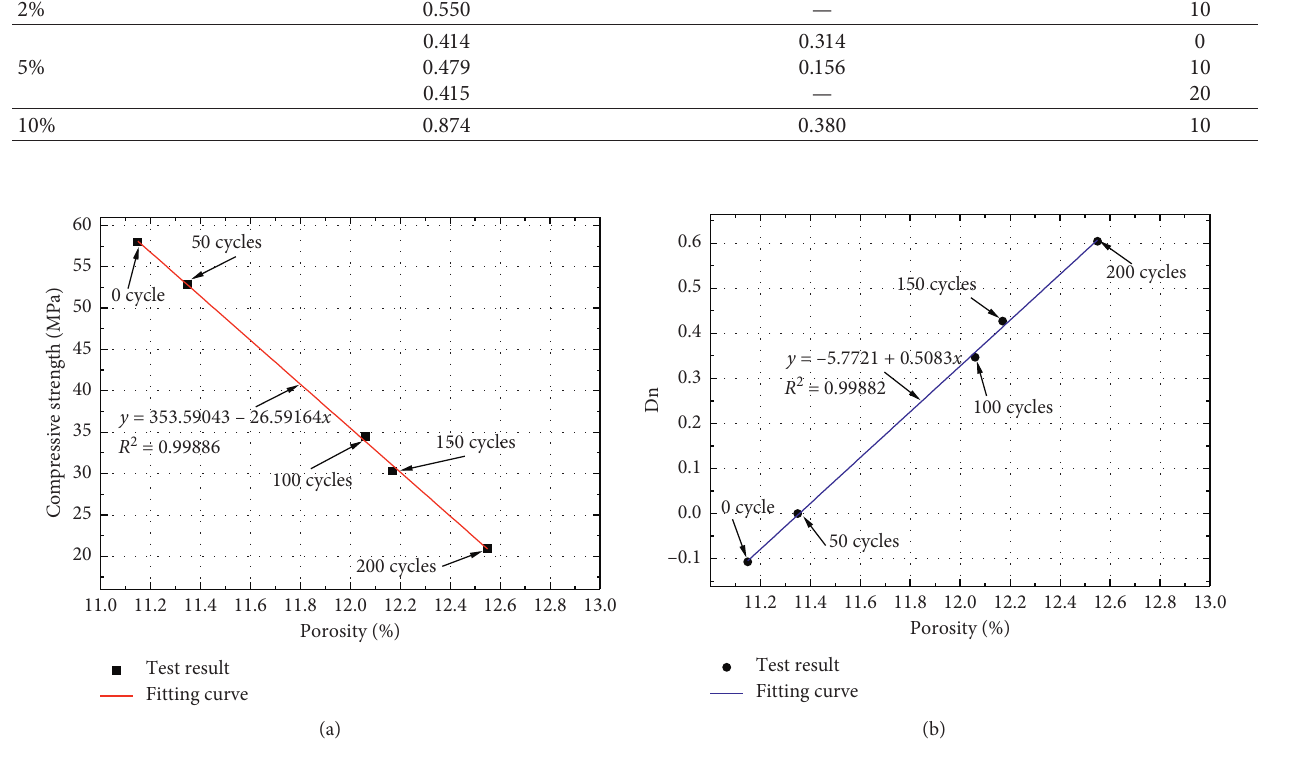
Figure 13: Analysis of macroscopic properties and